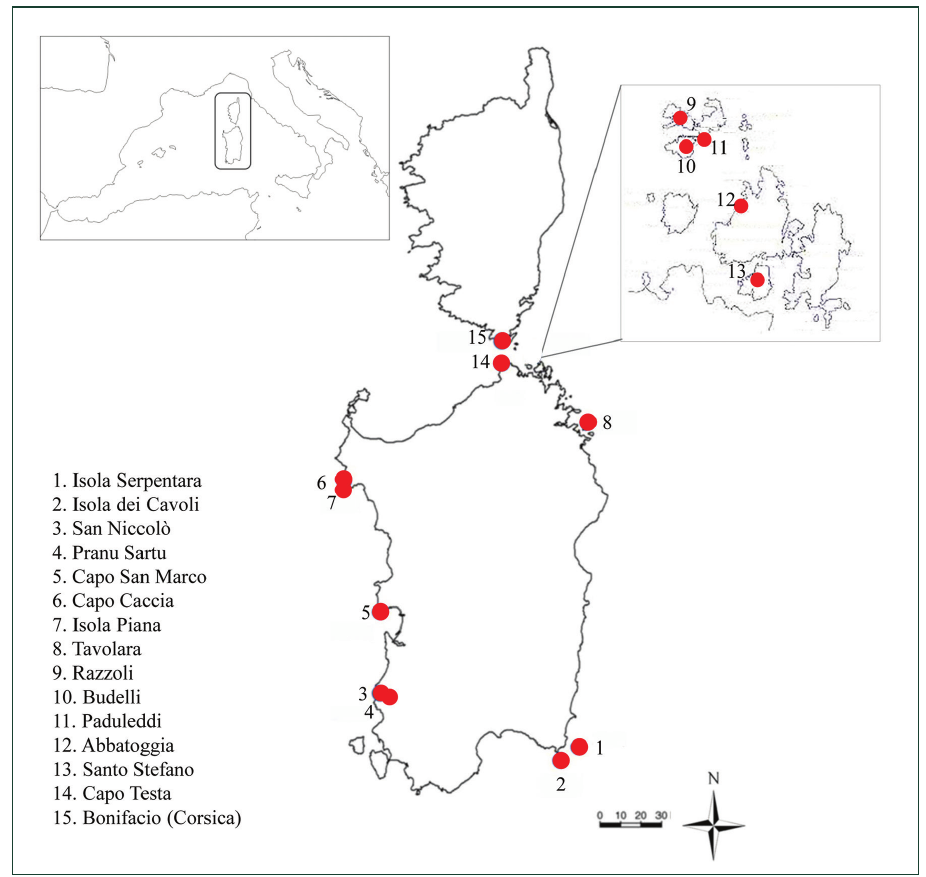
Figure 6. Geographic range and distribution map of Ferula arrigonii